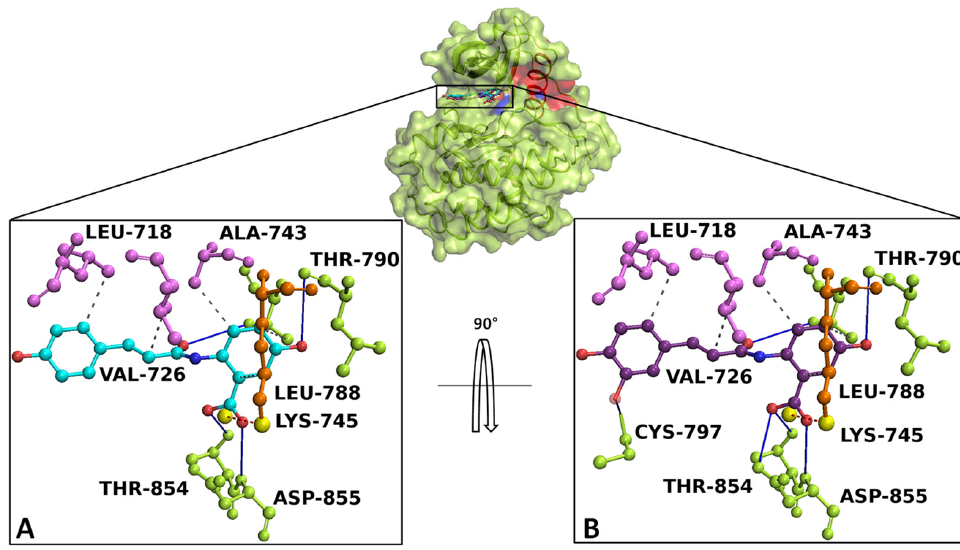
Figure 10. Overview of EGFR docked with AnvA and AvnC. The EGFR 3D structure is depicted in green surface/cartoon. The α C helix region and DFG motif are represented in red and blue surface/cartoon, respectively. AvnA and AvnC were reported as cyan and purple sticks/balls, respectively. The enlargement shows the interaction network of ( A ) AvnA and ( B ) AvnC in complex with the binding residues of EGFR after the docking simulation. The residues involved in hydrogen bonds (blue continue line), salt bridge (red dotted line), and hydrophobic interactions (grey dotted line) are indicated as green, orange, and violet sticks/balls, respectively. The yellow sphere, represent the charge centre of atoms forming the salt bridge. To clarify, the hydrogens were